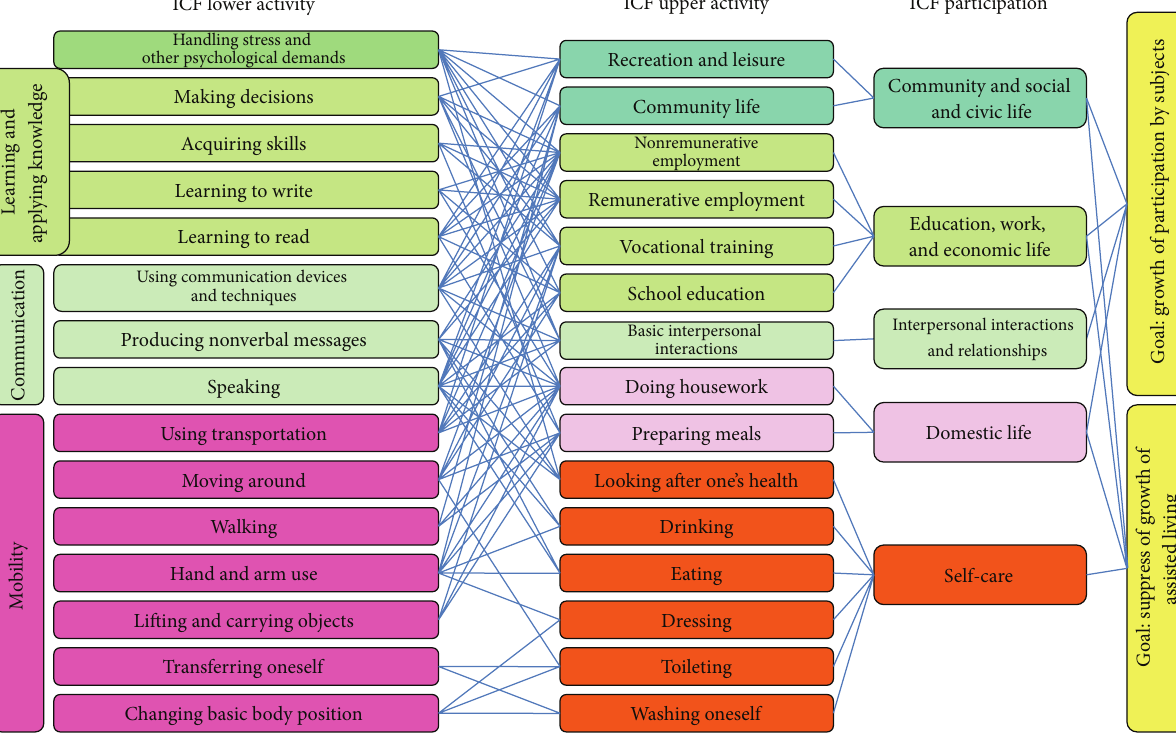
Figure 10: Image of relation among many factors of several levels of functioning.